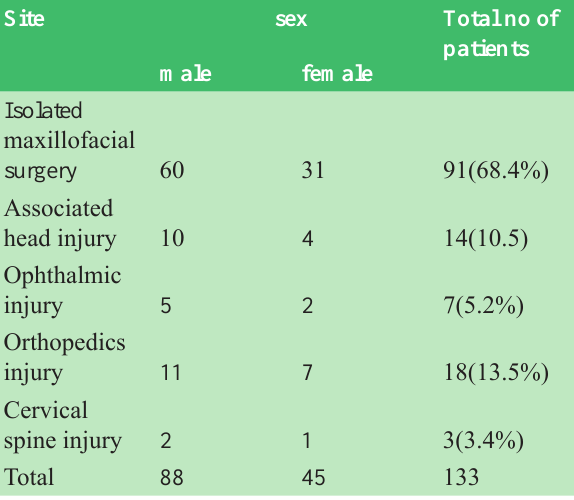
Table3: Associated injuries with maxillofacial